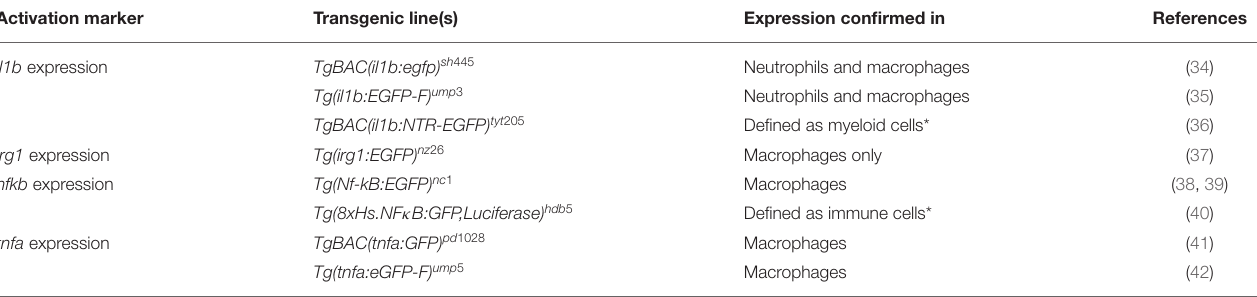
TABLE 2 | Examples of transgenic lines routinely used to visualize and differentiate phagocyte activation states. Activation marker